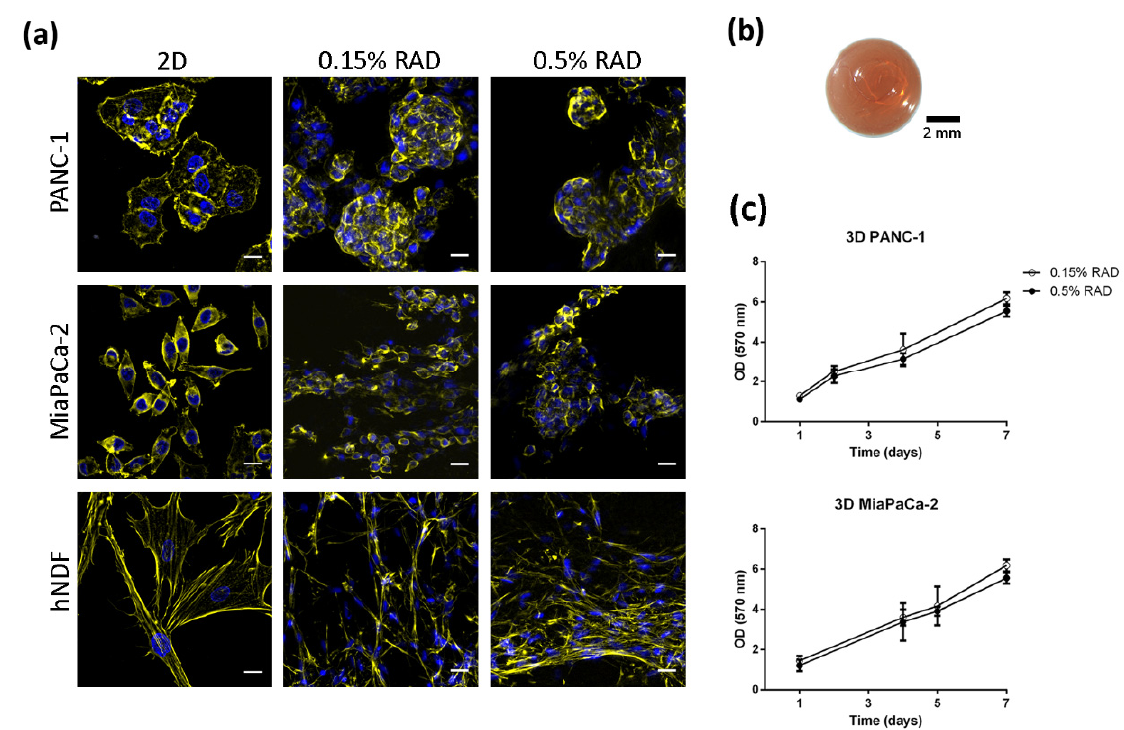
Figure 1. Cell culture in 3D RAD16-I scaffolds. ( a ) Cell morphology in 2D and 3D cultures. Actin (Phalloidin, pseudo-colored in yellow) and nuclei (DAPI, blue) staining of PANC-1, MiaPaCa-2 and hNDF cells cultured in classic 2D dishes and RAD16-I 3D scaffolds at two different peptide concentrations. Scale bars represent 20 µm; ( b ) macroscopic view of 3D constructs stained with Congo red for clearer visualization; ( c ) growth curves of PANC-1 and MiaPaCa-2 cells in 0.15% and 0.5% RAD16-I.